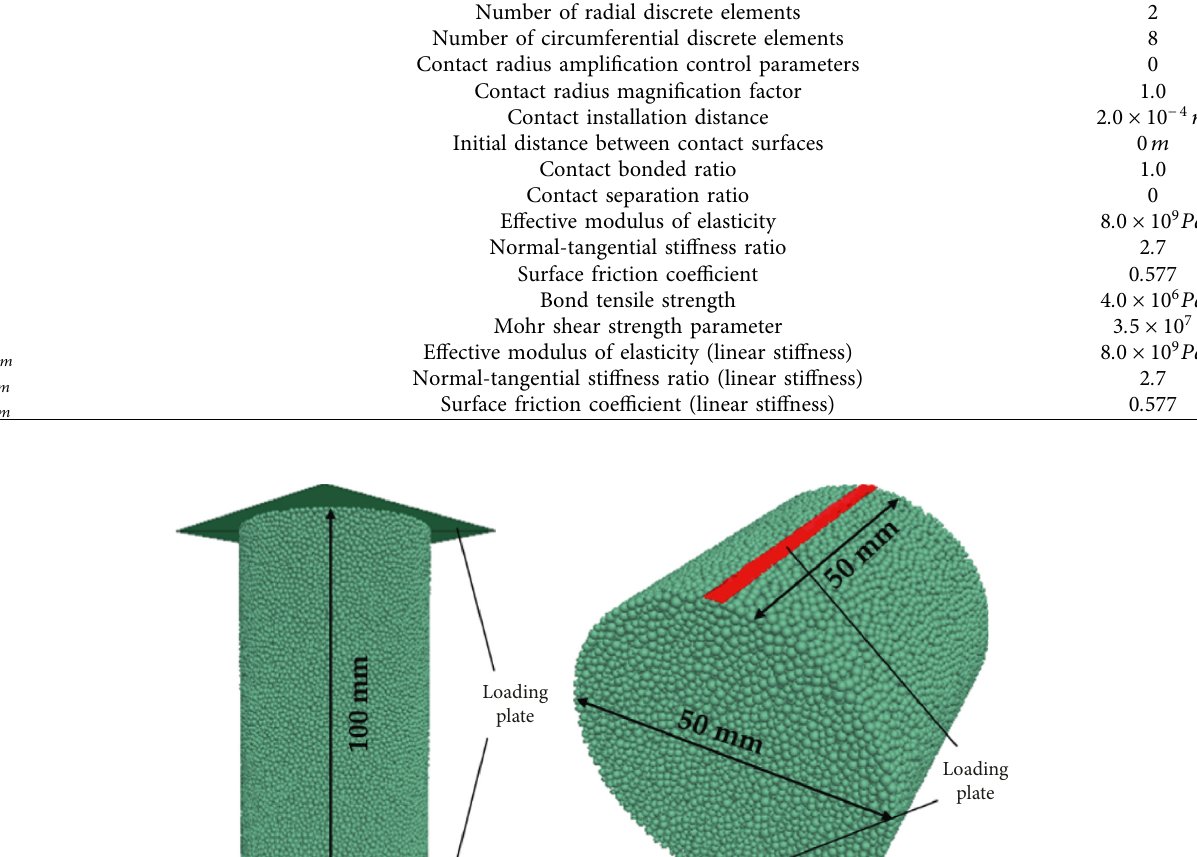
Table 1: Contact generation parameters and contact mechanics parameters based on the discrete contact surface bonded model. Mesoscopic